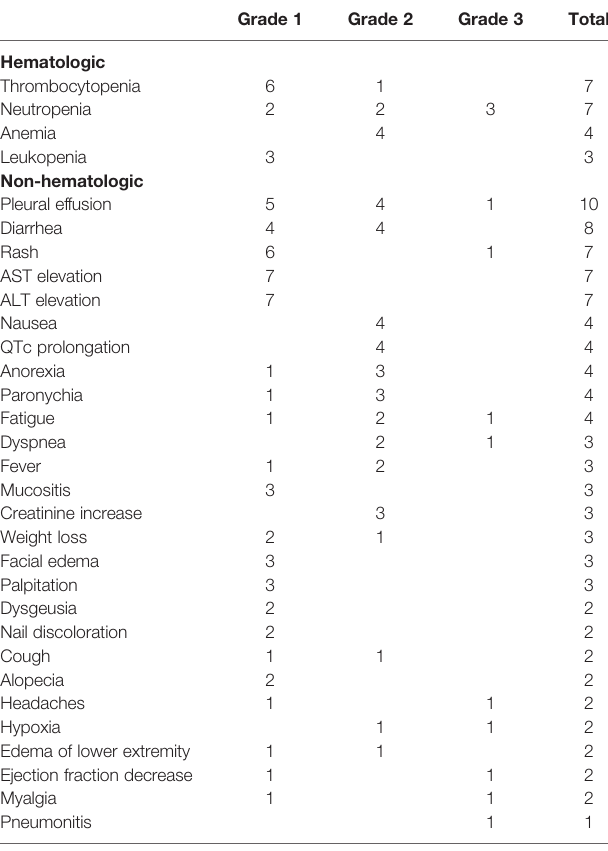
TABLE 2 | Treatment-related adverse events experienced in more than one patient*